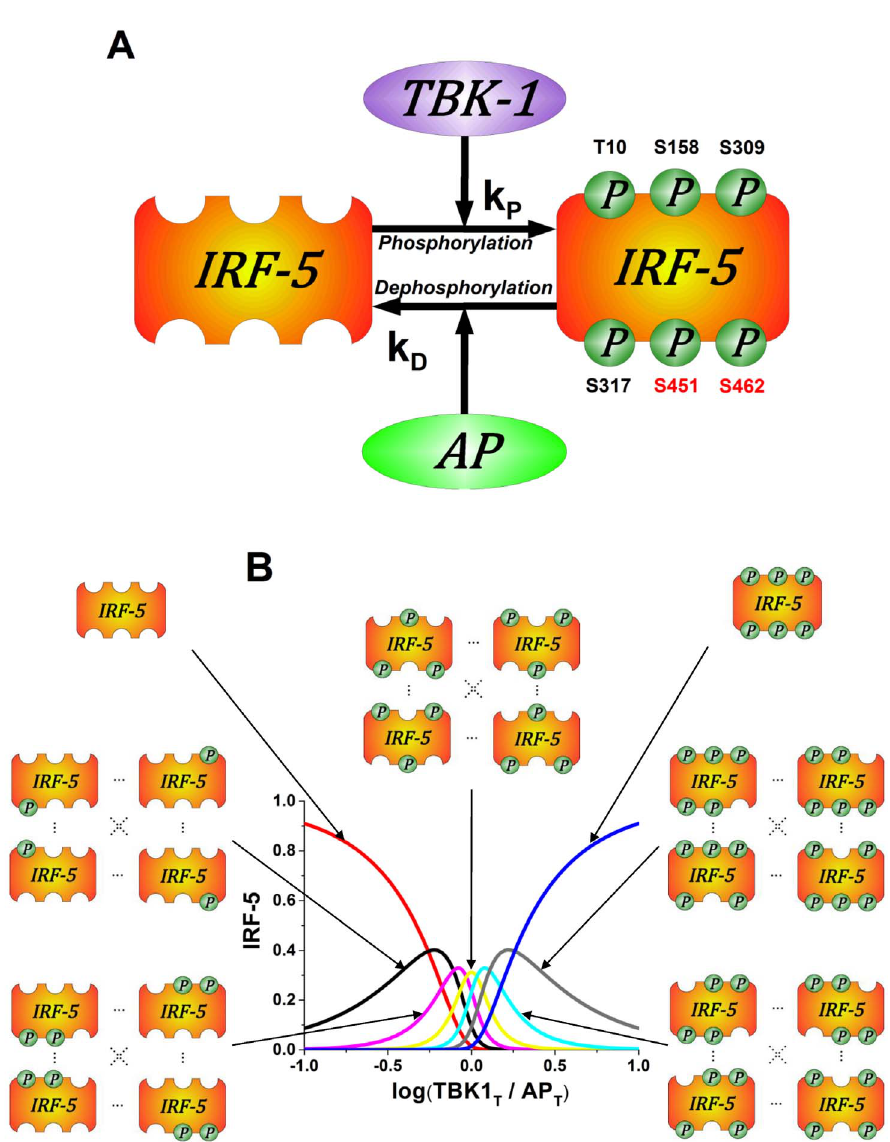
Figure 3. Multisite phosphorylation enables switching between multiple T cell phenotypes. (A) Schematic diagram of IRF-5 phosphorylation and dephosphorylation by TBK-1 and AP, respectively, represents one of many intracellular multiphosphorylation examples observed in the immune system. Experimental evidence suggests that proteins phosphorylated at different phosphorylation sites may have selective activity [37,61] and give rise to distinct T cell populations [62]. (B) Computational model predictions for distribution of IRF-5 phosphorylated species. Extracellular environment is hypothesized ratio causing the distribution of IRF-5 phosphorylated species: one site phosphorylated (black), two (magenta), three (yellow), four (cyan), five (grey) and six (blue). According to the proposed model extracellular environment can actively change the ratio of IRF-5 phosphorylated species and thereby contribute to the mechanism of T cell plasticity by modulating the numbers of T cell phenotypes.